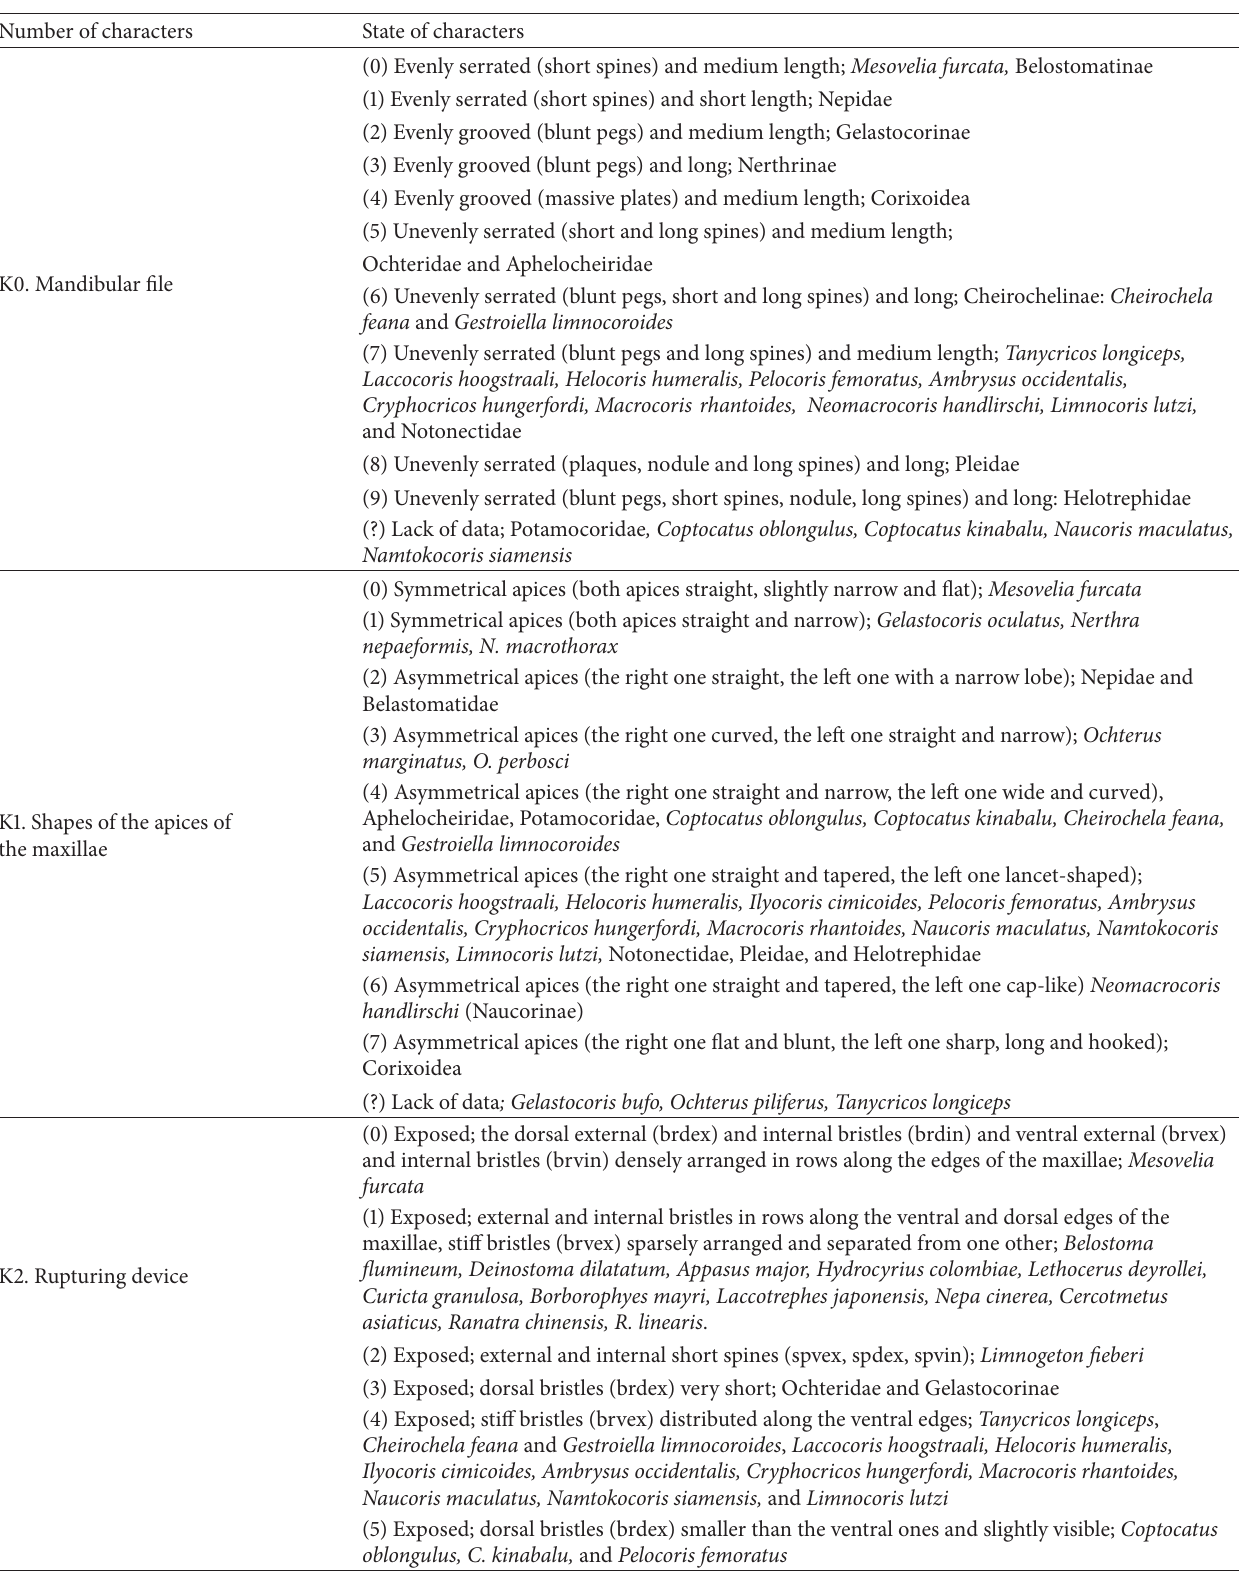
Table 2: New set of characters of the mouthparts—stylets bundle, sense organs, and labial segments of the Nepomorpha. Number of